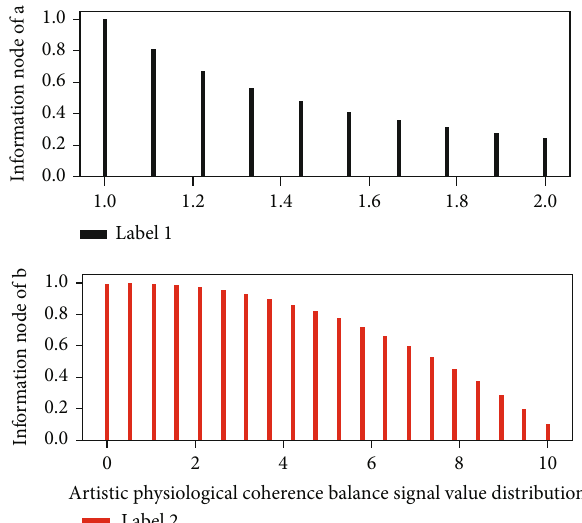
Figure 4: Value distribution of artistic physiological coherent balance